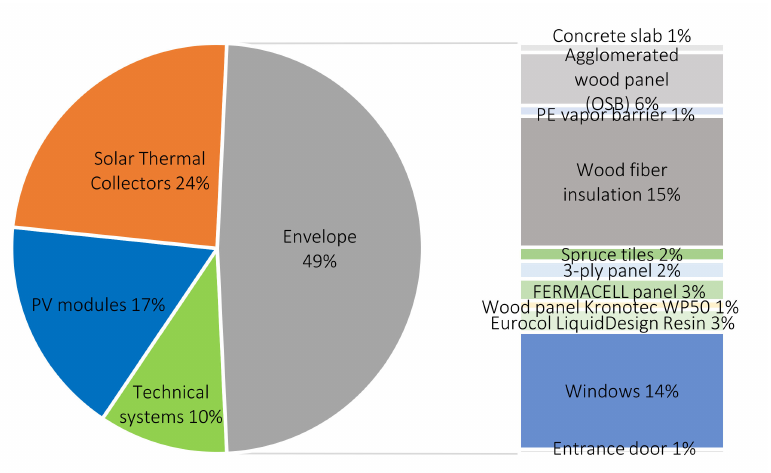
Figure 7. Life cycle assessment of the SolAce unit showing breakdown of different components’ contributions to embodied energy use as well as CO 2